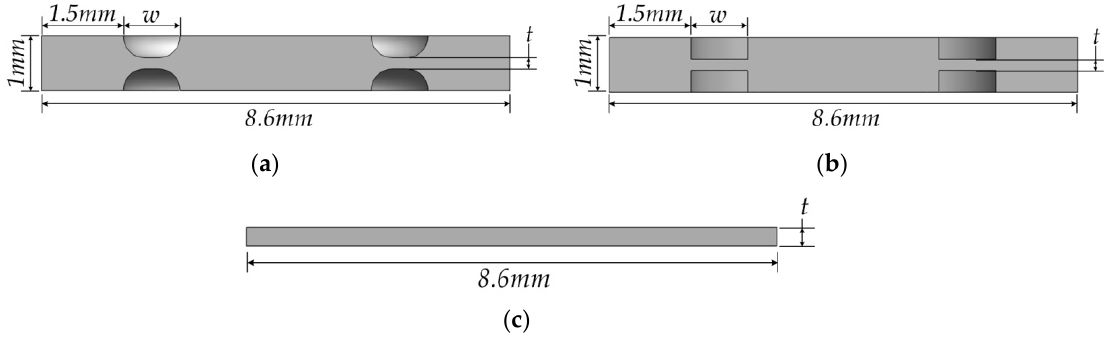
Figure 6. Shape and design parameter of three types of diaphragm: ( a ) round-grooved; ( b ) square grooved; ( c ) flat.